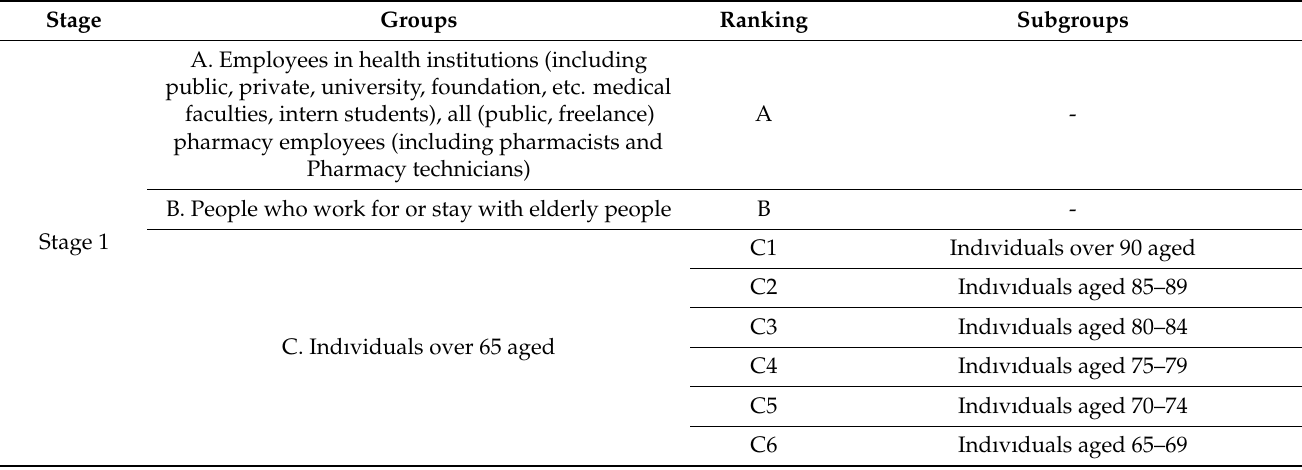
Table A1. Ranking of Groups to be